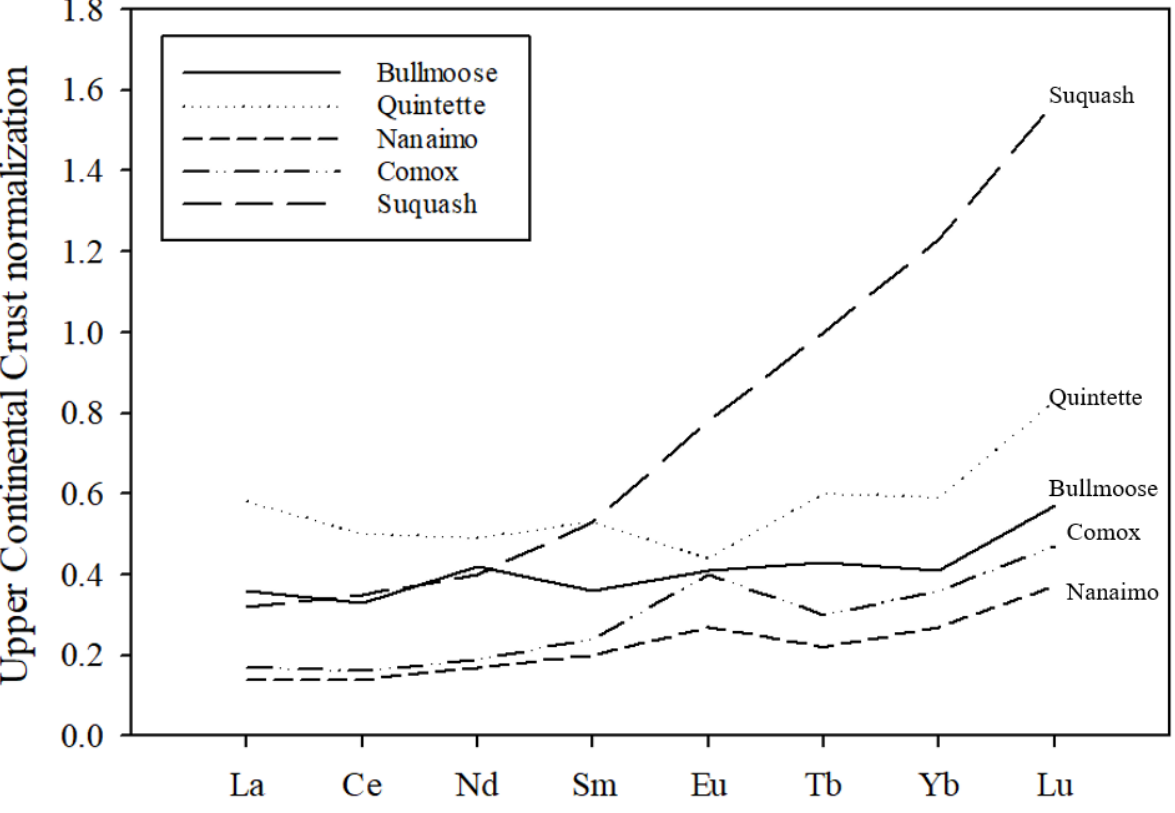
Figure 15. Upper Continental Crust normalization (after Taylor and McLennan [71]) for basin averages of Cretaceous coals from British Columbia [122].